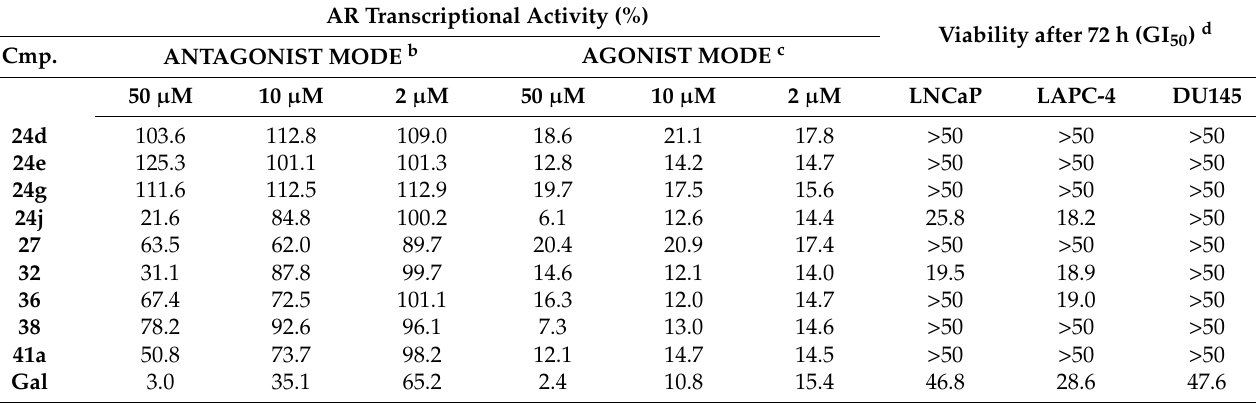
Table 3. AR transcriptional and antiproliferative activities of novel derivatives a . AR Transcriptional Activity (%)